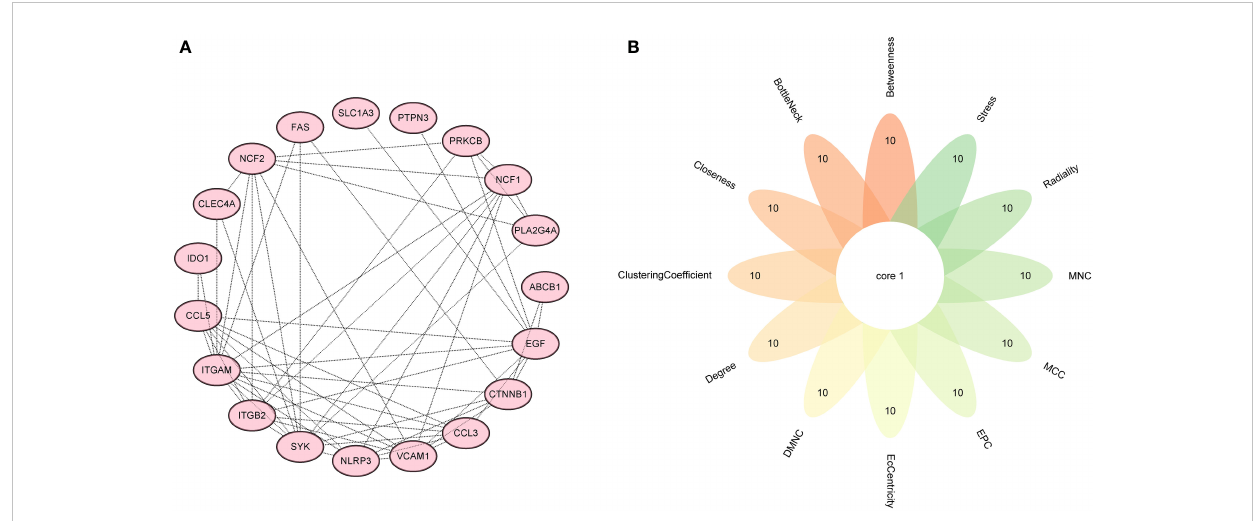
FIGURE 6 Screening hub genes by PPI network. (A) PPI network. (B) Venn diagrams for 12 algorithms in cytoHubba plugin. PPI, protein-protein interaction.